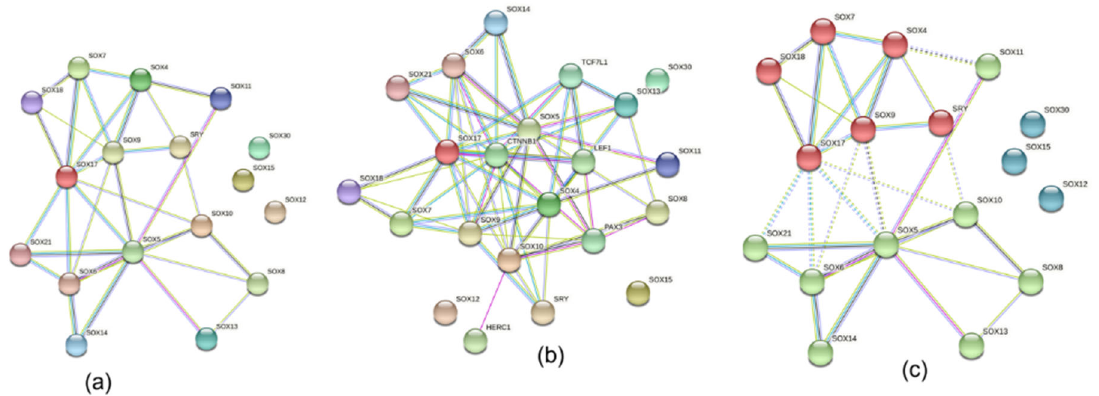
Figure 9. Sox protein interaction. Protein–protein interaction: ( a ) Sox proteins only; ( b ) predicted interactions with other proteins; ( c ) k means clustering. Network created using STRING (string ‐ db.org).